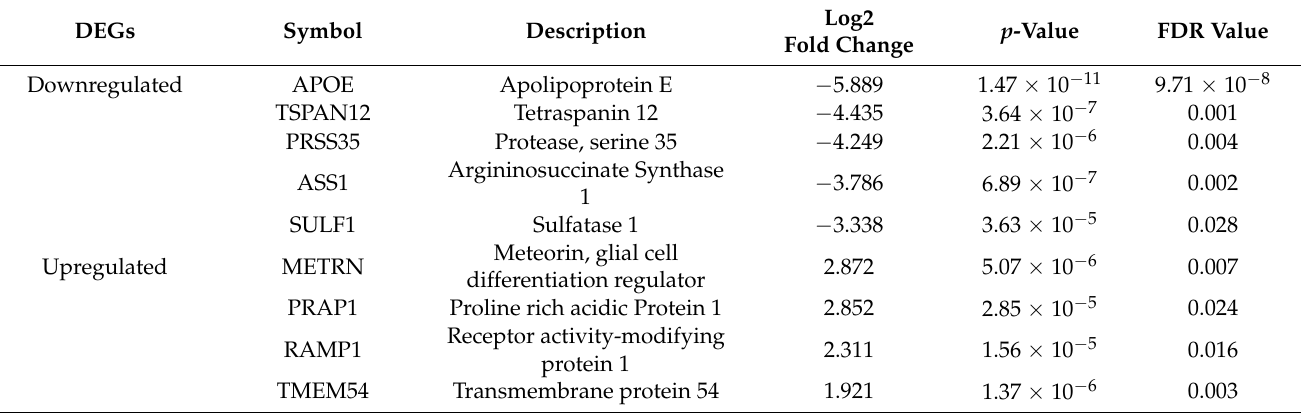
Table 4. The top 5 upregulated and top 4 downregulated DEGs in the lens fibre cells of the posterior subcapsular congenital cataract